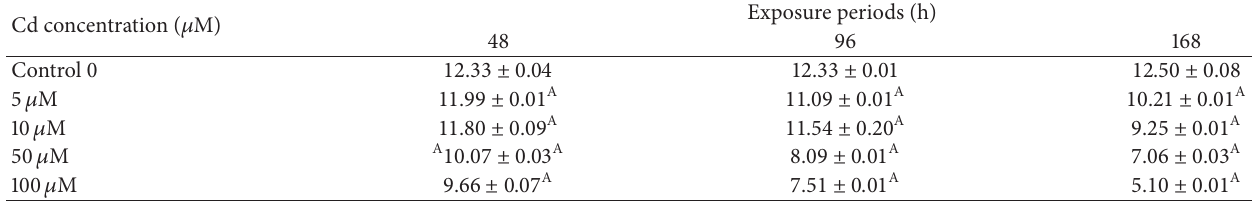
Table 3: Effect of Cd on the protein content (mgg − 1 fw) of B. monnieri at different concentrations and exposure periods. Cd concentration ( 𝜇 M)